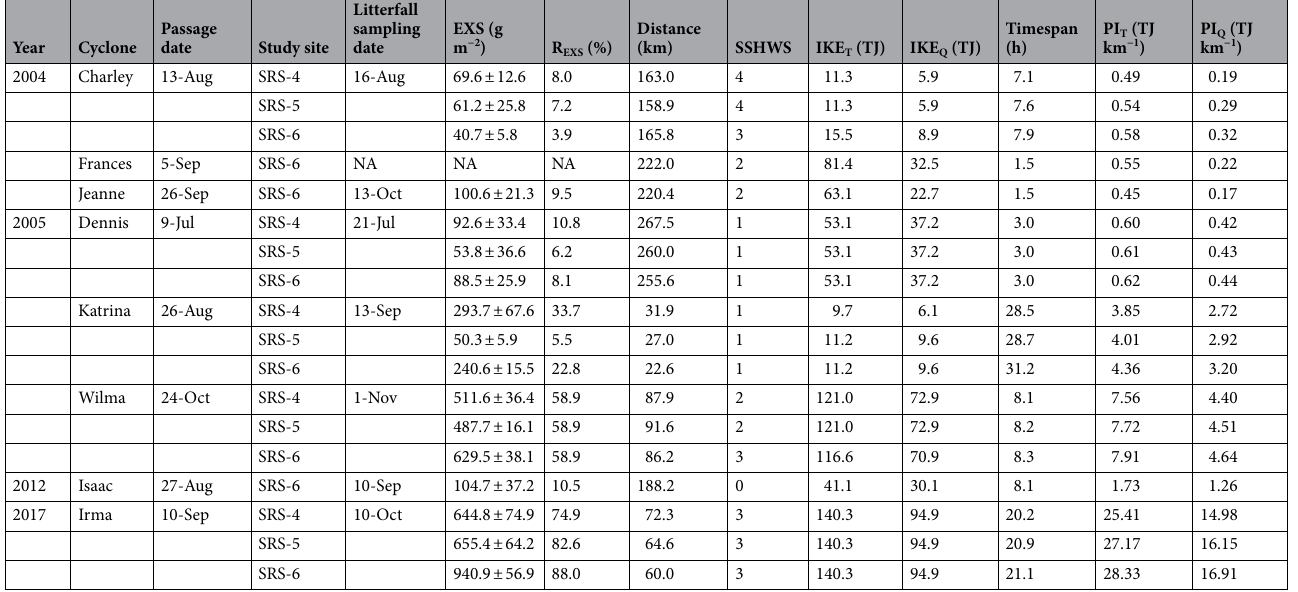
Table 1. Physical properties of tropical cyclones impacting mangrove study sites (SRS-4, SRS-5 and SRS-6) along the Shark River Estuary, Everglades, South Florida, USA in the period 2004–2018, including associated litterfall values. EXS total amount of excess litterfall material, R EXS ratio of the EXS value to annual litterfall baseline (2001–2003), IKE integrated kinetic energy, TJ terajoules, SSHWS Saffir-Simpson Hurricane Wind Scale, IKE T IKE value considering all cyclone quadrants (NE, NW, SE, SW), IKE Q IKE value for selected cyclone quadrants, PI cumulative energy of a cyclone for a timespan and distance, PI T PI value based on IKE T for all quadrants, PI Q PI value using IKE Q for selected quadrants, “ NA ” not measured. Listed distance, SSHWS, IKE T, and IKE Q values were recorded when the cyclone was the closest to study sites. See “Methods” for further information and calculations.